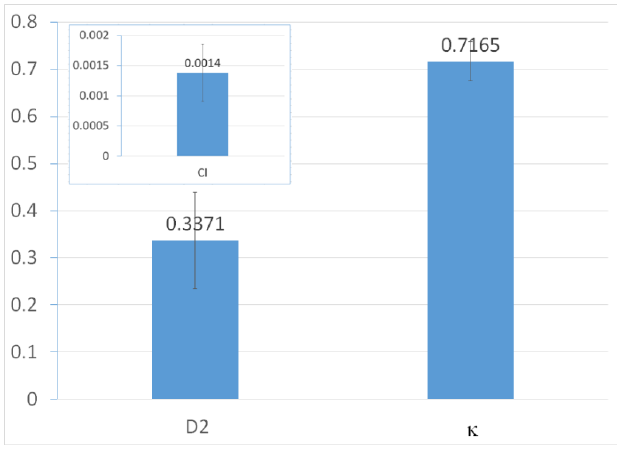
Figure 4. Average value for ten cells with identical inputs. Table 2 . Results for the parameter fitting to the model (4 for DoE settings).